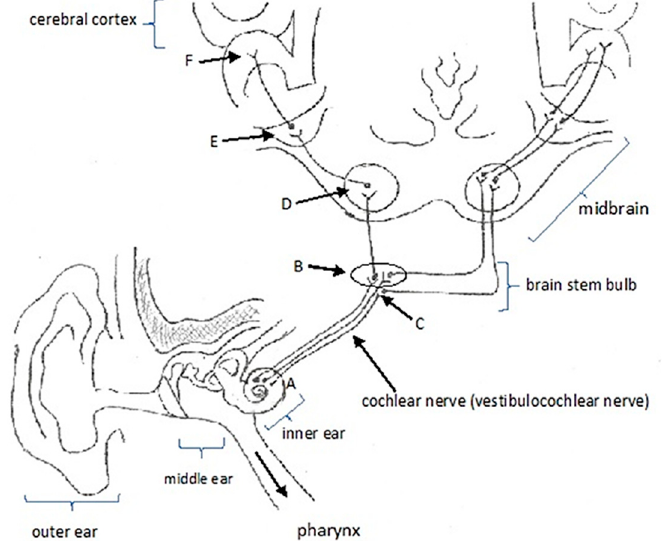
Figure 7. Schematic representation of the auditory pathway through the vestibulocochlear nerve (VIII cranial nerve) showing the path of the auditory pathway from the cochlear nerve which starts from the spiral ganglion of the cochlea (A) located in the inner ear. Next, the cochlear nerve goes to the superior portion of the brainstem bulb, where this nerve follows the homolateral path through the synapse in the dorsal cochlear nucleus (B) and follows the contralateral path through the synapse in the ventral cochlear nucleus (C). Then, the nerve continues with synapses in the inferior colliculus (D) and medial geniculate nuclei (E) (midbrain) and another synapse in the anterior transverse temporal gyrus (F) of the cerebral cortex.